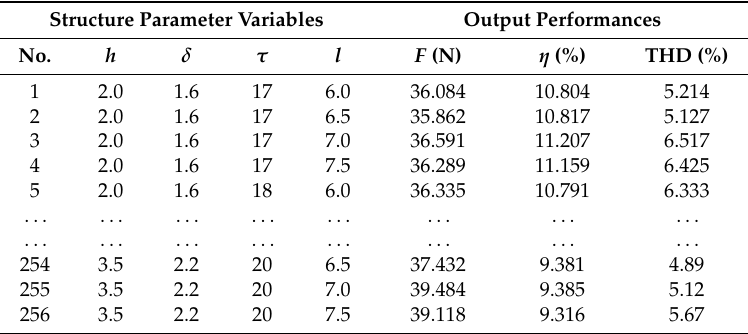
Table 8. Sample data space based on